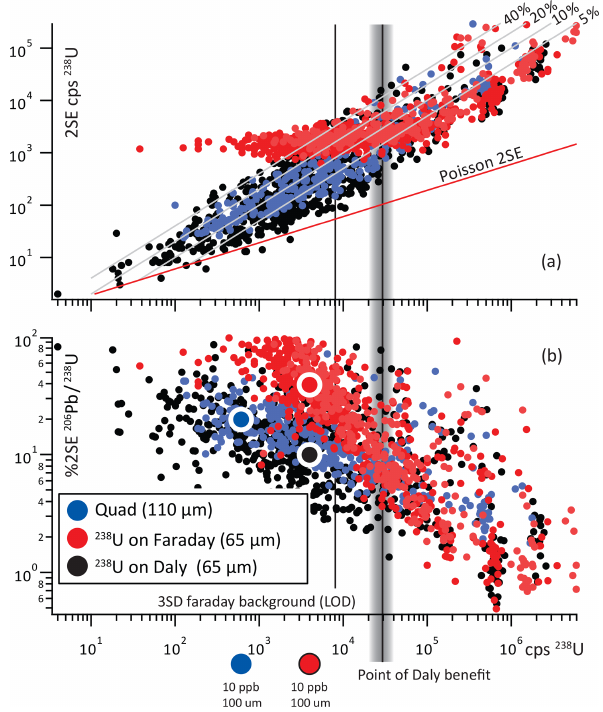
Figure 1. Relation between counts per second 238 U and uncertainty of 238 U (a) , and 206 Pb / 238 U (b) . Grey lines in A are %2 SE uncer- tainties of 238 U. The three experiments show the same trend in un- certainty vs. counts per second at count rates above ∼ 30 kcps 238, but below that, the uncertainty of measurements in Experiment F (238 on the Faraday) increases significantly compared to Experi- ments D and Q. Although Experiments D and Q (red and blue sym- bols) show similar trends, the sensitivity gain using the P3D leads to significant improvements in spot uncertainty; large symbols rep- resent expected uncertainties for a 100µm spot at 10ppb U, and the vertical offset between them represents the gain or loss in precision for such an analyses depending on the instrumentation